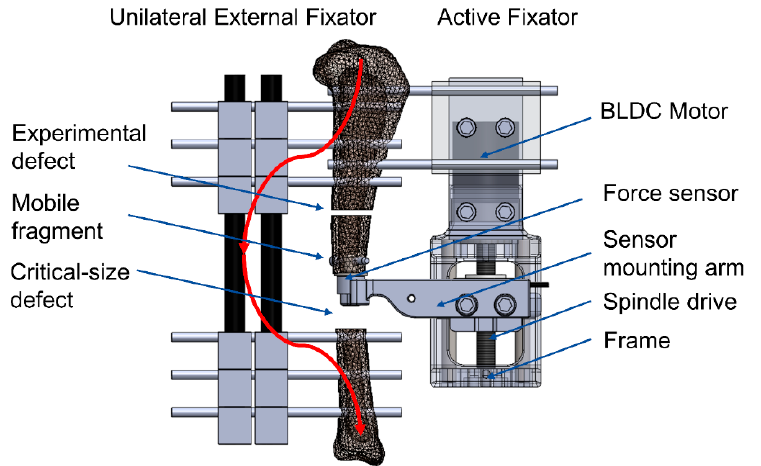
Figure 1. Configuration of the fracture model. The unilateral external fixator transfers forces from physiological weight-bearing from the proximal to the distal bone fragments (red line), while the experimental defect remains unaffected. The Brushless Direct Current (BLDC) motor actuates the spindle drive, which in turn moves the mobile bone fragment along the longitudinal bone axis.